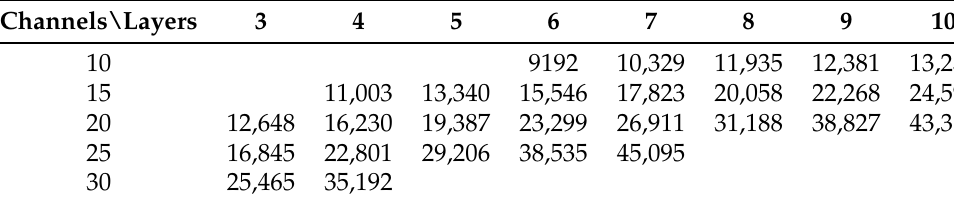
Table 6. LUT estimation charts.